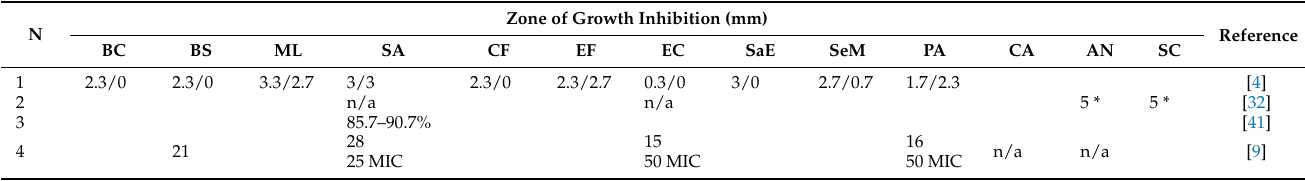
Table 3. Antimicrobial effects of HSOs.